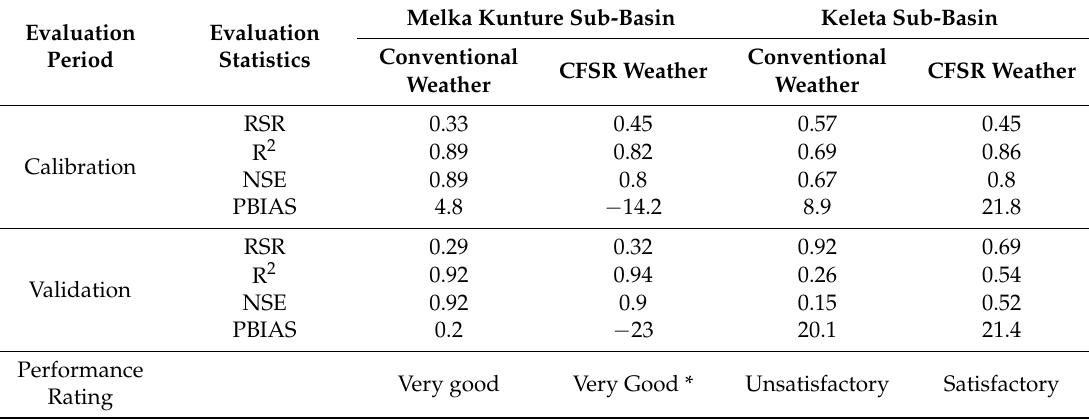
Table 3. Model performance evaluation statistics for the two sub-basins using the two weather datasets.